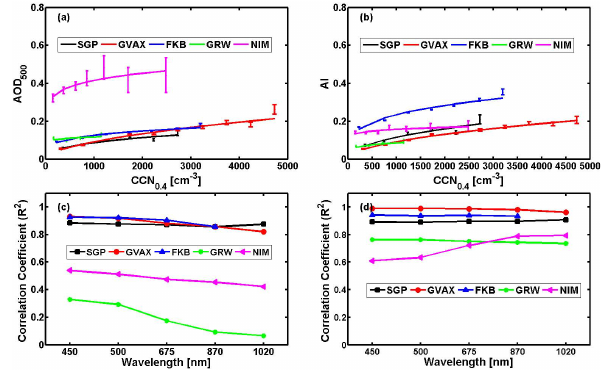
Fig. 1. (a) Relationship between AOD at 500nm and CCN 0 . 4 , (b) relationship between AI and CCN 0 . 4 (c) their correlation coeffi- cients, and (d) same as (c) , but for AI in lieu of